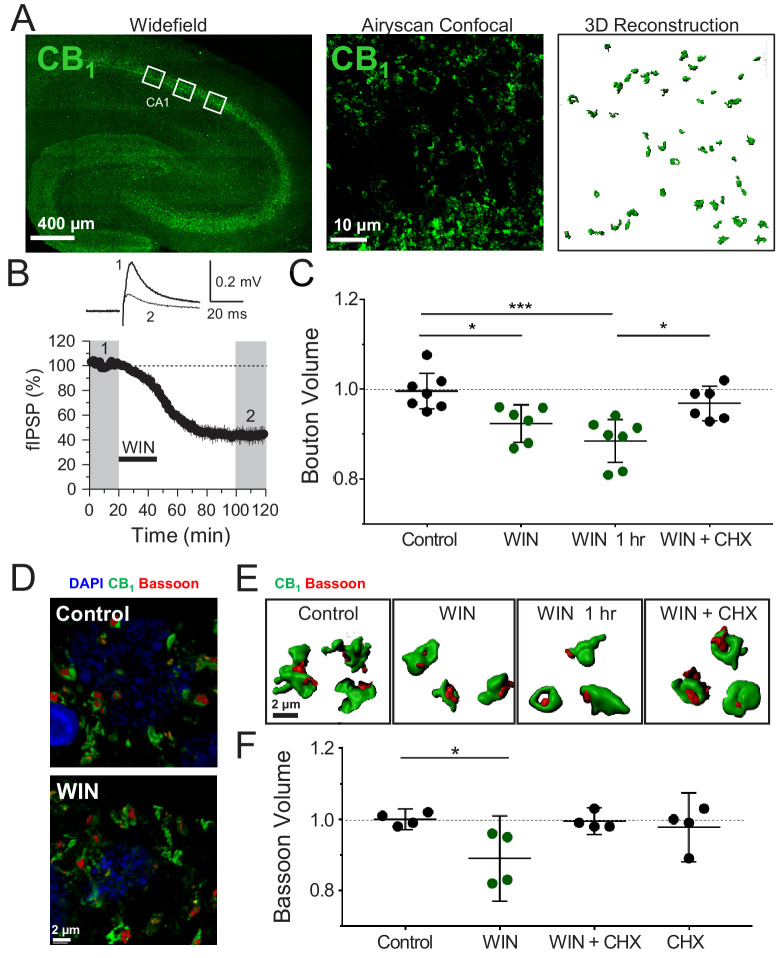
Induction of CB1-iLTD is associated with a reduction in CB1+ bouton size.(A) Left, representative stitched widefield confocal of hippocampal CB1 immunolabeling. White boxes indicate where high-magnification images were acquired (as seen in center panel). Center, High-resolution Airyscan confocal maximum projection used for 3D reconstruction of individual boutons in CA1 stratum pyramidale. Right, 3D reconstruction of Airyscan confocal image shown in center panel. (B) Top, representative extracellular field inhibitory postsynaptic potentials (fIPSPs) recorded in the CA1 pyramidal cell body layer in acute hippocampal slices before and after WIN treatment (5 µM, 25 min). Bottom, summary time-course plot showing WIN-induced depression; n = 3 slices, three animals. For all electrophysiology figures, representative traces correspond to the gray-shaded areas and in the summary time-course plots (averaged summary data expressed as normalized change from baseline ± S.E.M.). Shaded boxes in all electrophysiology figures correspond to when plasticity was analyzed with respect to baseline and when representative traces were collected and averaged. (C) Quantification of mean bouton volume per slice normalized to Control. Activation of CB1 receptors with 5 µM WIN for 25 min led to decreased bouton volume that remained 1 hr after WIN treatment and was blocked by treatment with cycloheximide (CHX, 80 µM, applied throughout the experiment). Control: 1.0 ± 0.02 vs. WIN: 0.92 ± 0.02 vs. WIN + 1 hr: 0.89 ± 0.02 vs. CHX + WIN: 0.97 ± 0.02 (Mean ± S.E.M.); F[3,22]=8.682; p=0.0005, one-way ANOVA with post-hoc Tukey test for multiple comparisons. Control vs. WIN: CI[0.005,0.14], p=0.03. Control vs. WIN 1 hr: CI[0.05,0.18], p=0.0005. WIN 1 hr vs. WIN + CHX: CI[−0.11,0.03], p=0.012. n = number of slices (three images/slice, 1–2 slices/rat, six rats/condition). For all structural plasticity figures, data are presented as points representing mean bouton volume per slice with a horizontal black line representing the mean per condition and the vertical line indicating 95% confidence interval (CI). 95% CIs are given as CI[lower CI, upper CI]. p-Values are exact. Refer to Figure 1—figure supplement 1A for distribution of individual bouton values. (D) Representative 3D reconstruction widefield images of Bassoon labeling inside CB1+ boutons. (E) Representative single CB1 boutons with Bassoon reconstructed in 3D. (F) Quantification of mean Bassoon volume per slice normalized to Control after 25 min WIN treatment revealed a reduction in active zone volume as measured using Bassoon immunolabeling that was blocked by treatment with cycloheximide (CHX, 80 µM, applied throughout the experiment). Control: 1.0 ± 0.01 vs. WIN: 0.89 ± 0.04 vs. CHX + WIN: 1.0 ± 0.01 vs. CHX: 0.98 ± 0.03 (Mean ± S.E.M.); F[3,12]=4.11, p=0.032, one-way ANOVA with post-hoc Tukey test for multiple comparisons. Control vs. WIN: CI[0.004,0.22], p=0.042. n = number of slices (three images/slice, 1–2 slices/rat, three rats/condition). Refer to Figure 1—figure supplement 1D for distribution of individual Bassoon values.